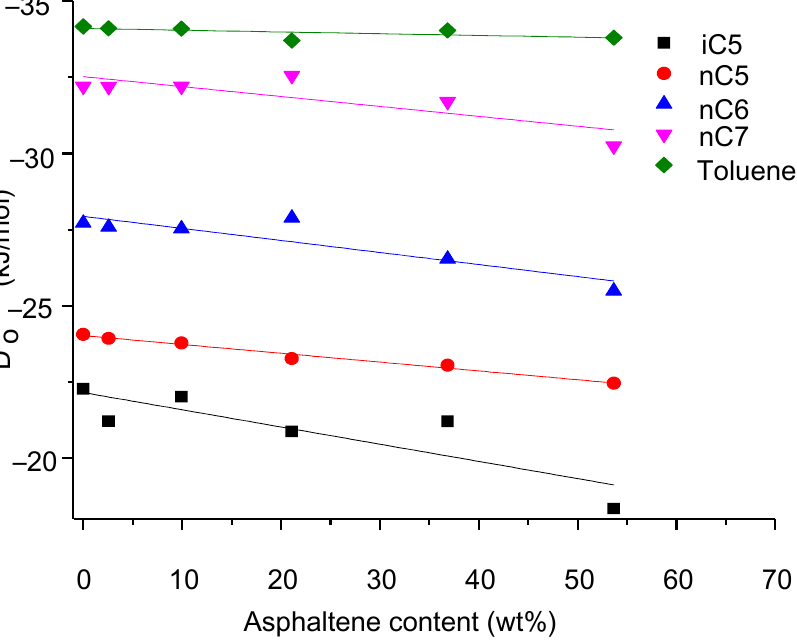
Figure 5. Linear plots for enthalpy of solution, ∆ H 0 , vs. the different asphalting contents for five hydrocarbons iC5, nC5, nC6, nC7, and Toluene.